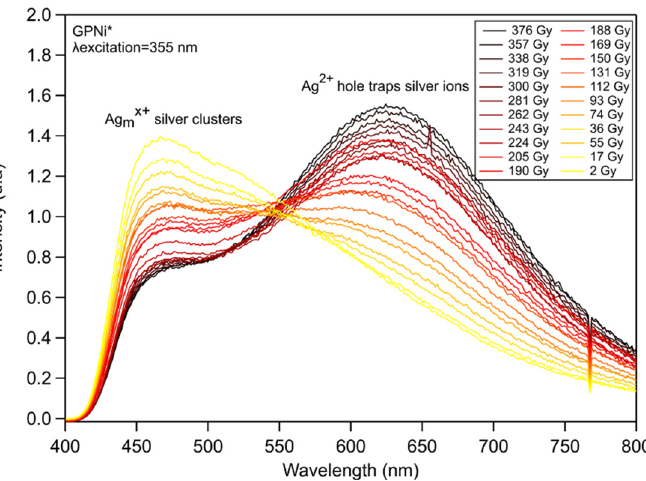
Figure 7. Radio-photoluminescence measurement of the GPNi* glass for the inscribed structure [39].